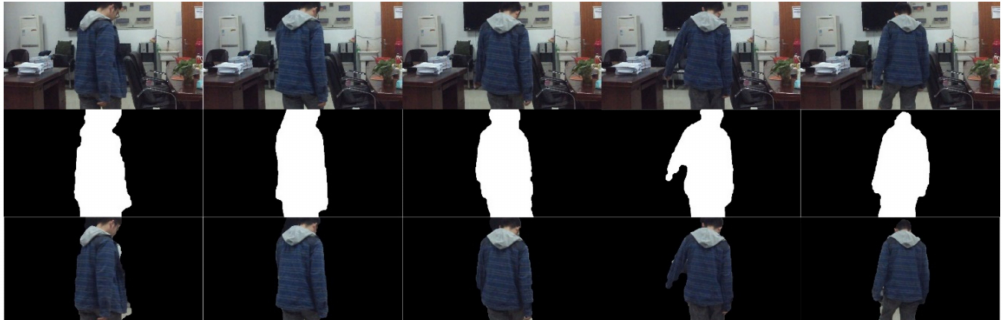
Figure 9. The target area extraction results of 80~84 frames. From top to bottom are the corrected images, the moving target binarized image extracted by the target detection method in this paper, the superimposed display of the binarized image, and the corrected image.